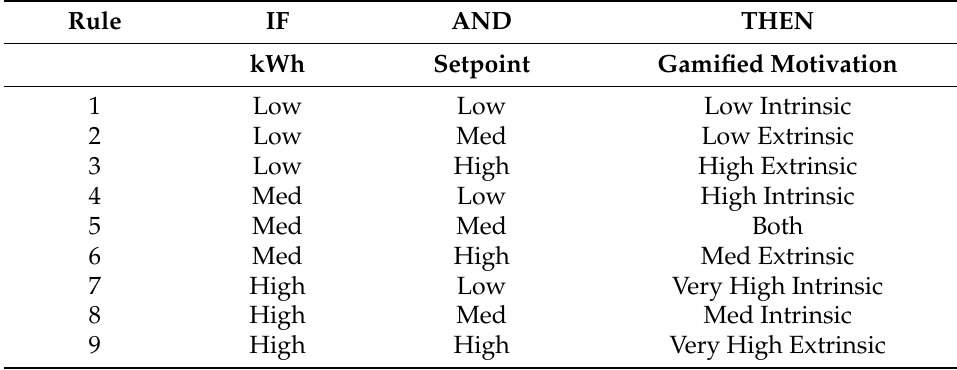
Table 7. Fuzzy logic inference rules for winter